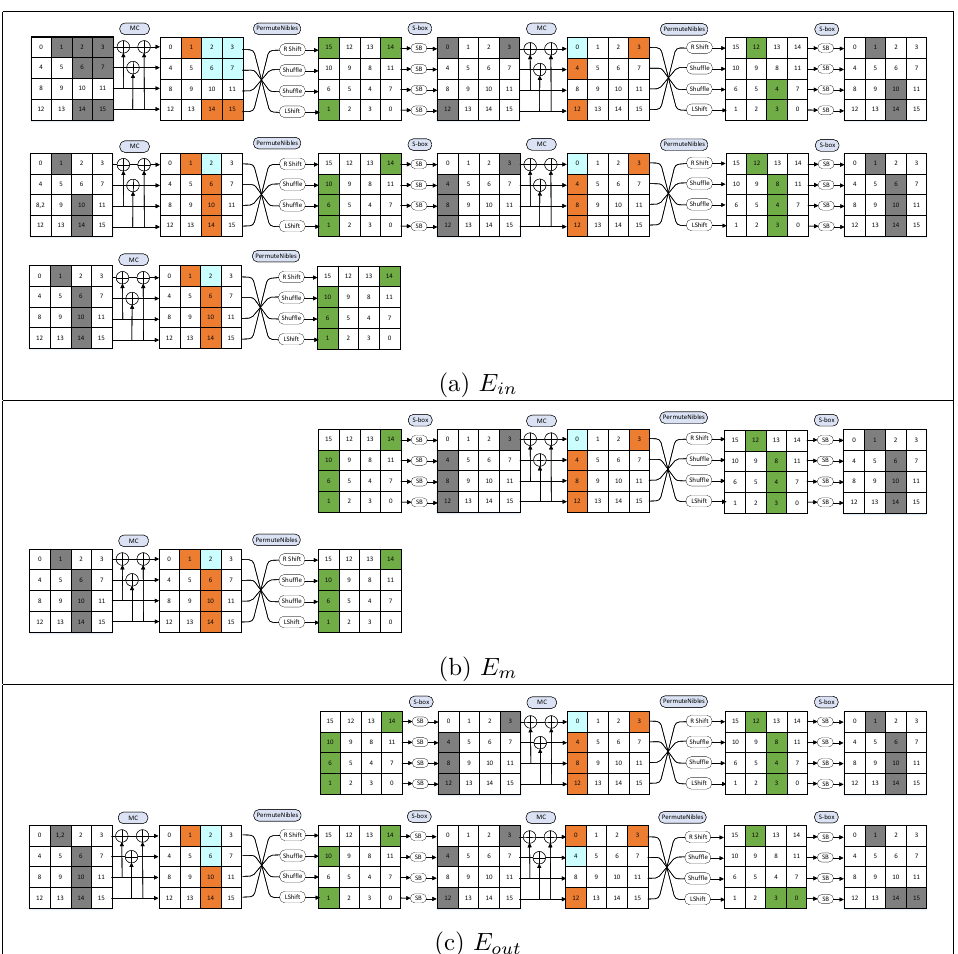
Figure 4: An expendable truncated trail for even rounds, where E in and E out denote the first 4 and the last 4 rounds, respectively and E m is a repeatable 2-round truncated trail that can be used as much as required. For example, to design a 10-round trail, this stage is repeated once in the current trail. The Cyan-colored cells are inactive due to cancellation after MC step, white-colored cells are inactive, and {Gray, Orange, Green} colors are active cells in different stages of the